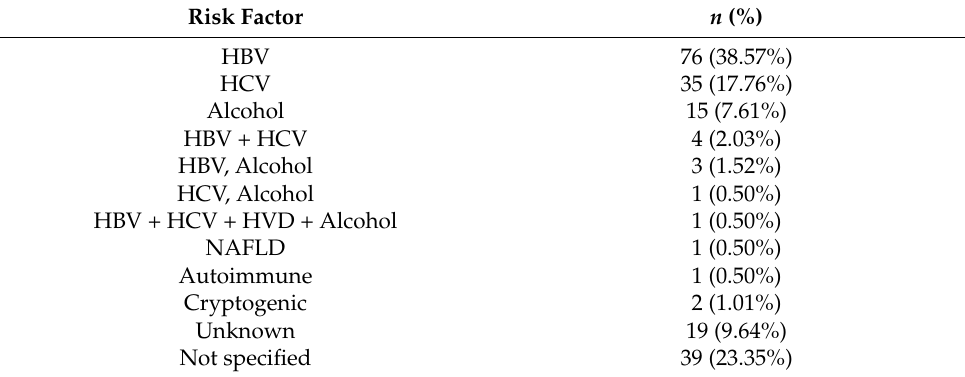
Table 3. Etiology of liver disease in patients with hepatocellular carcinoma.